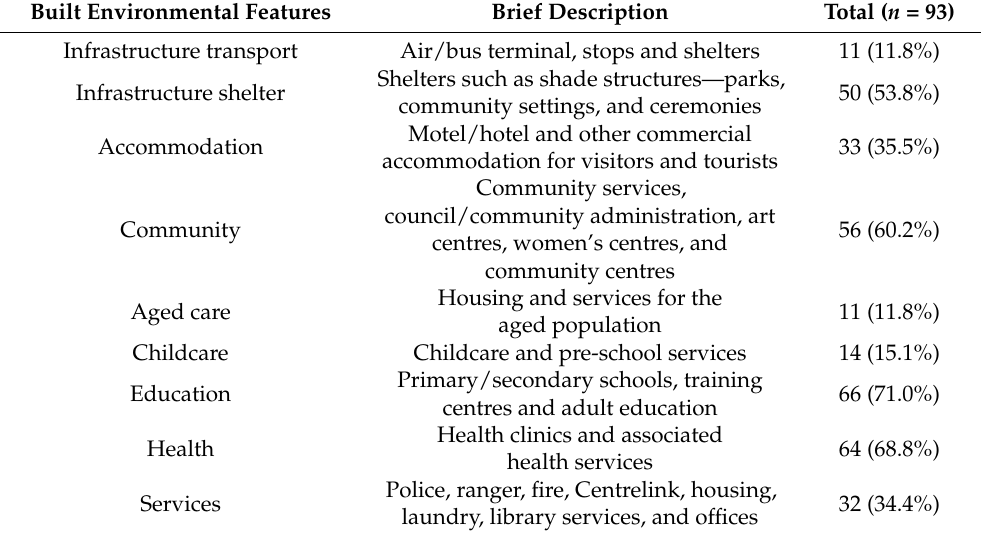
Table 1. Characteristics of ILOCs including proportion of ILOCs with relevant BE